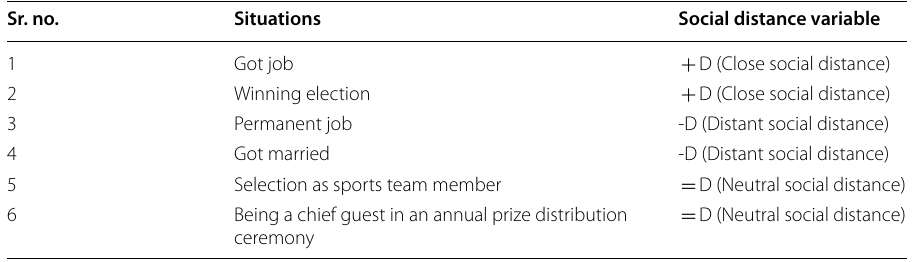
Table 1 Situations based on the contextual variable (social distance) Sr.